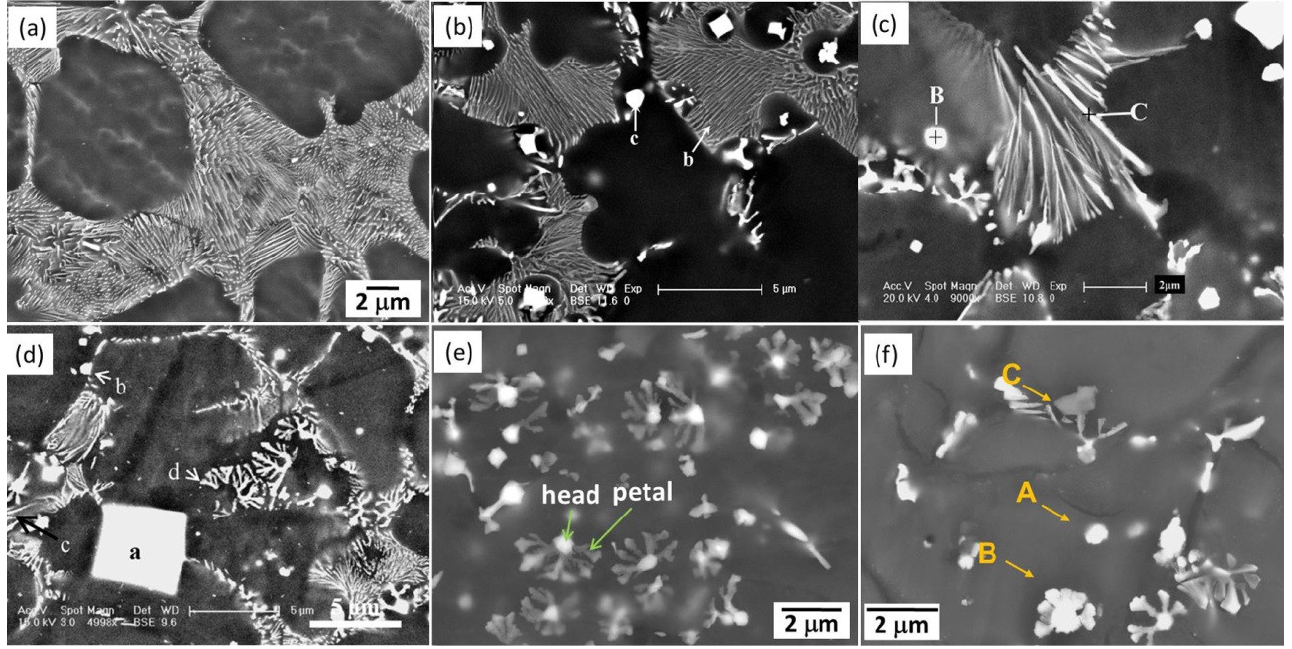
Figure 6. SEM images showing the microstructures of HPDC ( a ) ALa44; ( b ) ACe44 [95]; ( c ) APr44 [96]; ( d ) ANd44 [94]; ( e ) ASm44 [86]; ( f ) AGd44 [88]